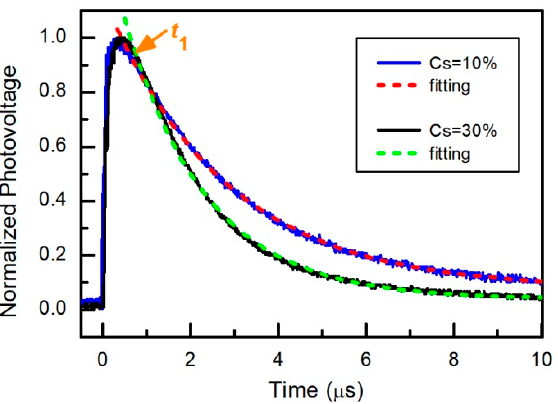
Figure 10. Photovoltage decay transients of the solar cells with different concentrations of Cs in perovskite layer. Excitation laser power density is 1.4 mW/cm 2 .